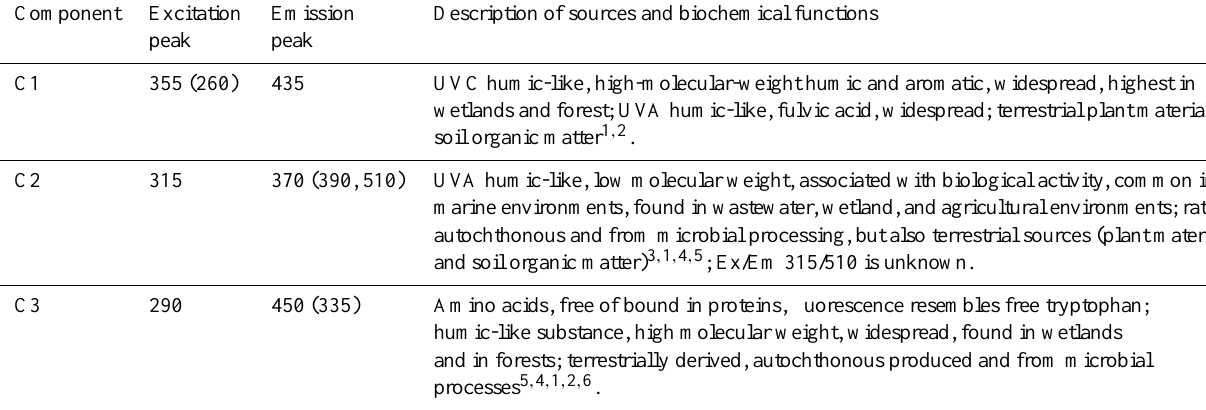
Table 2. The ecological definitions for the different PARAFAC components (Fig. 4) ∗ . Component